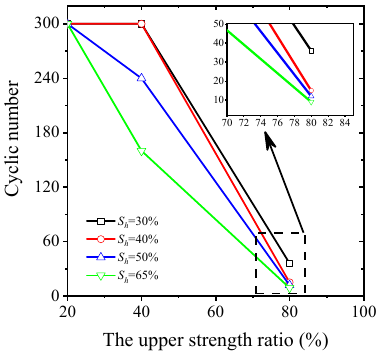
Figure 10. The relationship between the upper strength ratio and the cyclic number.